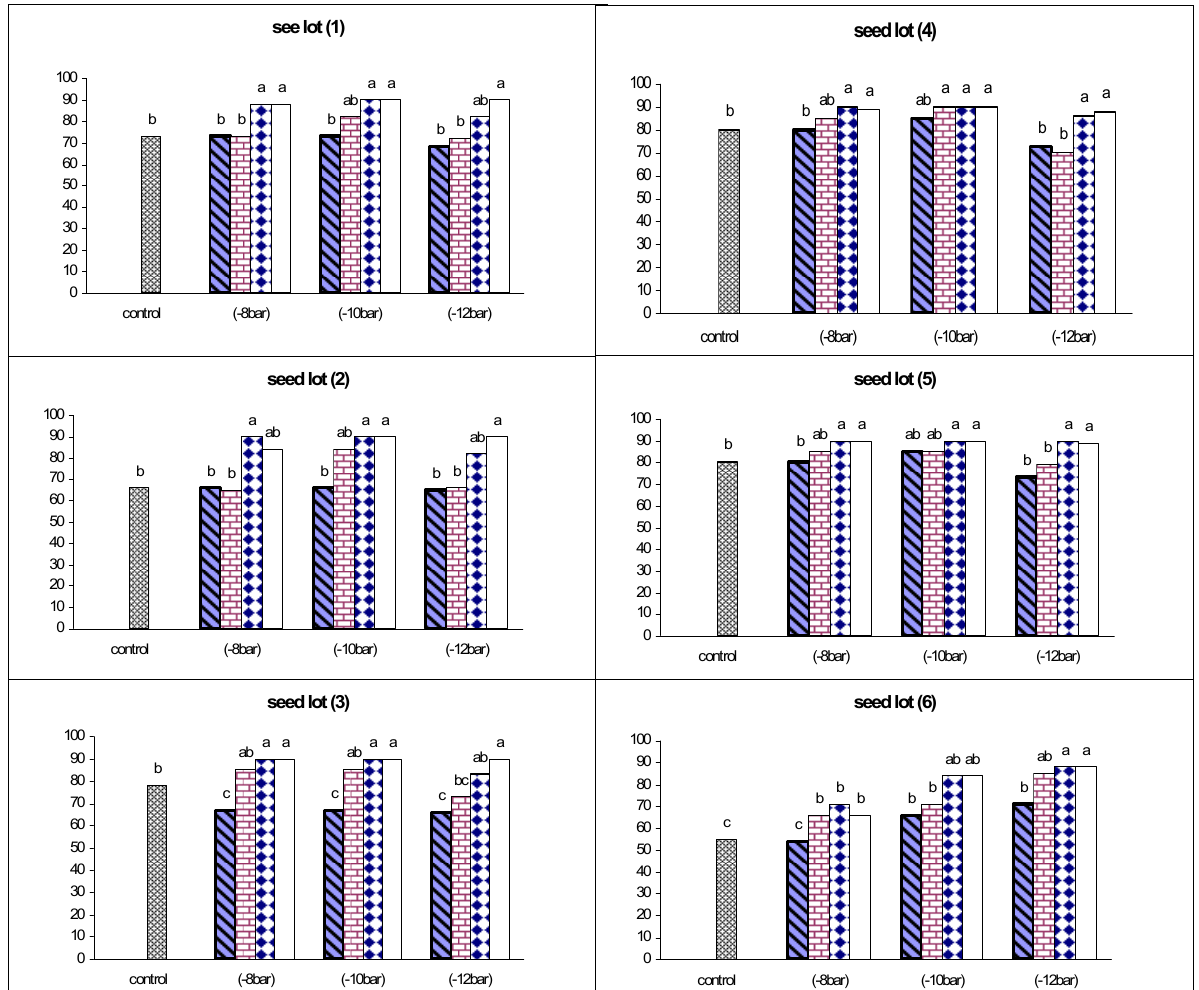
Fig. 1. Influence of osmotic potential levels of osmopriming treatments on the final germination percentage (FGP) in soybean seed lots (cv. ‘Sari’) under 12 , 24 , 36 and 48 hours durations. Horizontal axe shows priming with -8 bar; -10 bar; -12 bar; polyethylene glycol and 0 bar as a control group . Vertical axe is germination percentage